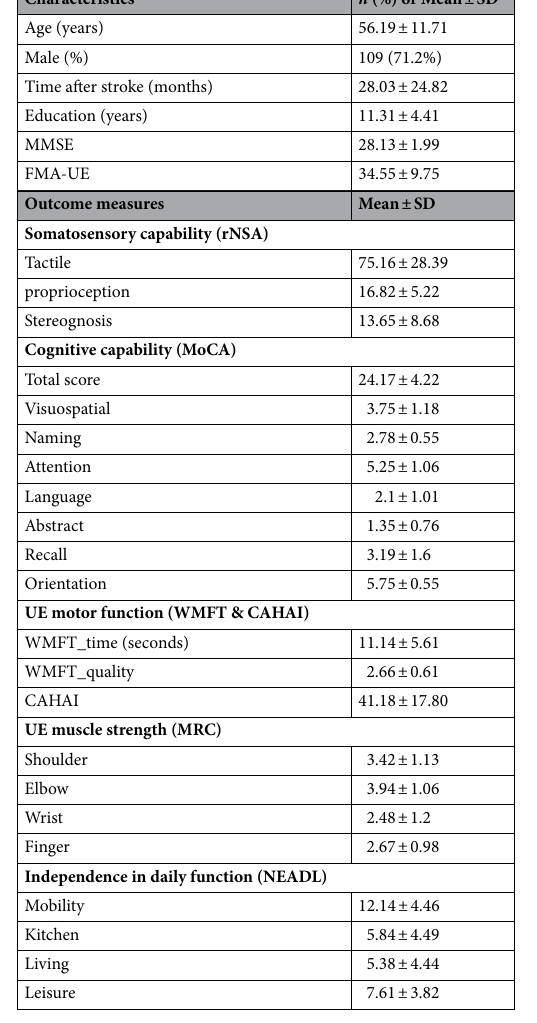
Table 1. Demographic and clinical characteristics, and results of outcome measures ( N = 153). MMSE: Mini- Mental State Examination; FMA-UE: Fugl-Meyer Assessment for upper extremity; rNSA: Revised Nottingham Sensory Assessment; MoCA: Montreal Cognitive Assessment; WMFT: Wolf Motor Function Test; CAHAI: Chedoke Arm and the Hand Activity Inventory; MRC: Medical Research Council scale; NEADL: Nottingham Extended Activities of Daily Living